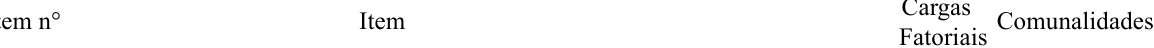
Cargas Fatoriais da junção da SATAQ e da Escala Masculina de Normatização de Padrões de Corpo- EMIC Item n° Fator 1: “Internalização”( α =0,95)